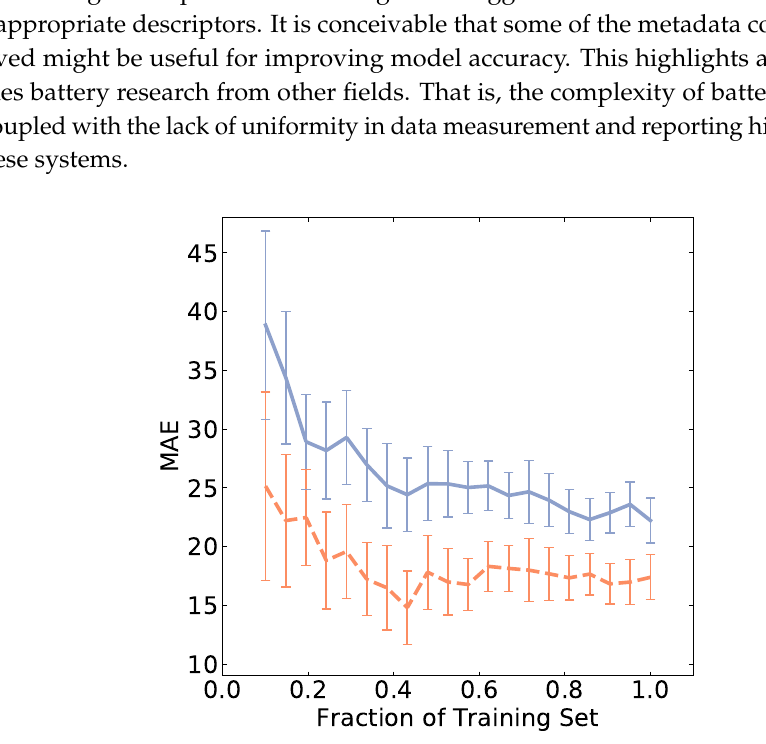
Figure 4. A decrease in mean absolute error (MAE) specific discharge capacity at 25 cycles (in mAh g − 1 ) is shown as a function of dataset size using the SVR algorithm. Blue (orange) represents the performance of the test (training) set. Error bars show the standard deviation (obtained by repeating the calculation 50 times, each with a random sampling of the training